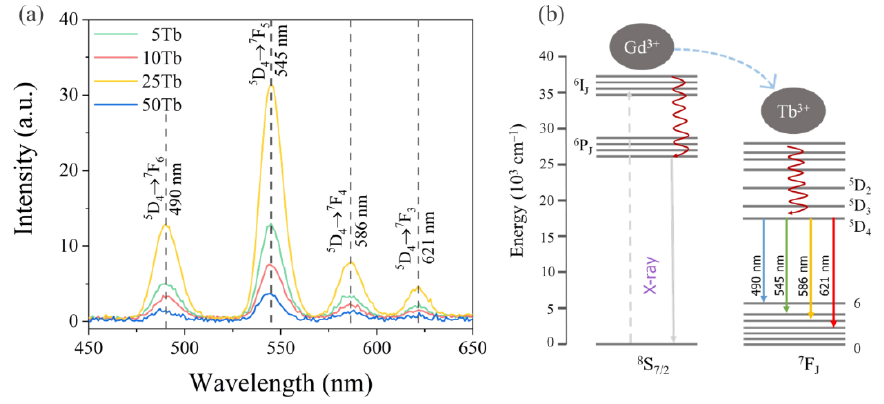
Figure 4. ( a ) X-ray-excited (U = 35 kV, I = 1.6 mA) optical luminescence spectra measured for x% of Tb 3+ ; ( b ) schematic energy-level diagram showing the processes occurring in BaGdF 5 :Tb 3+ .